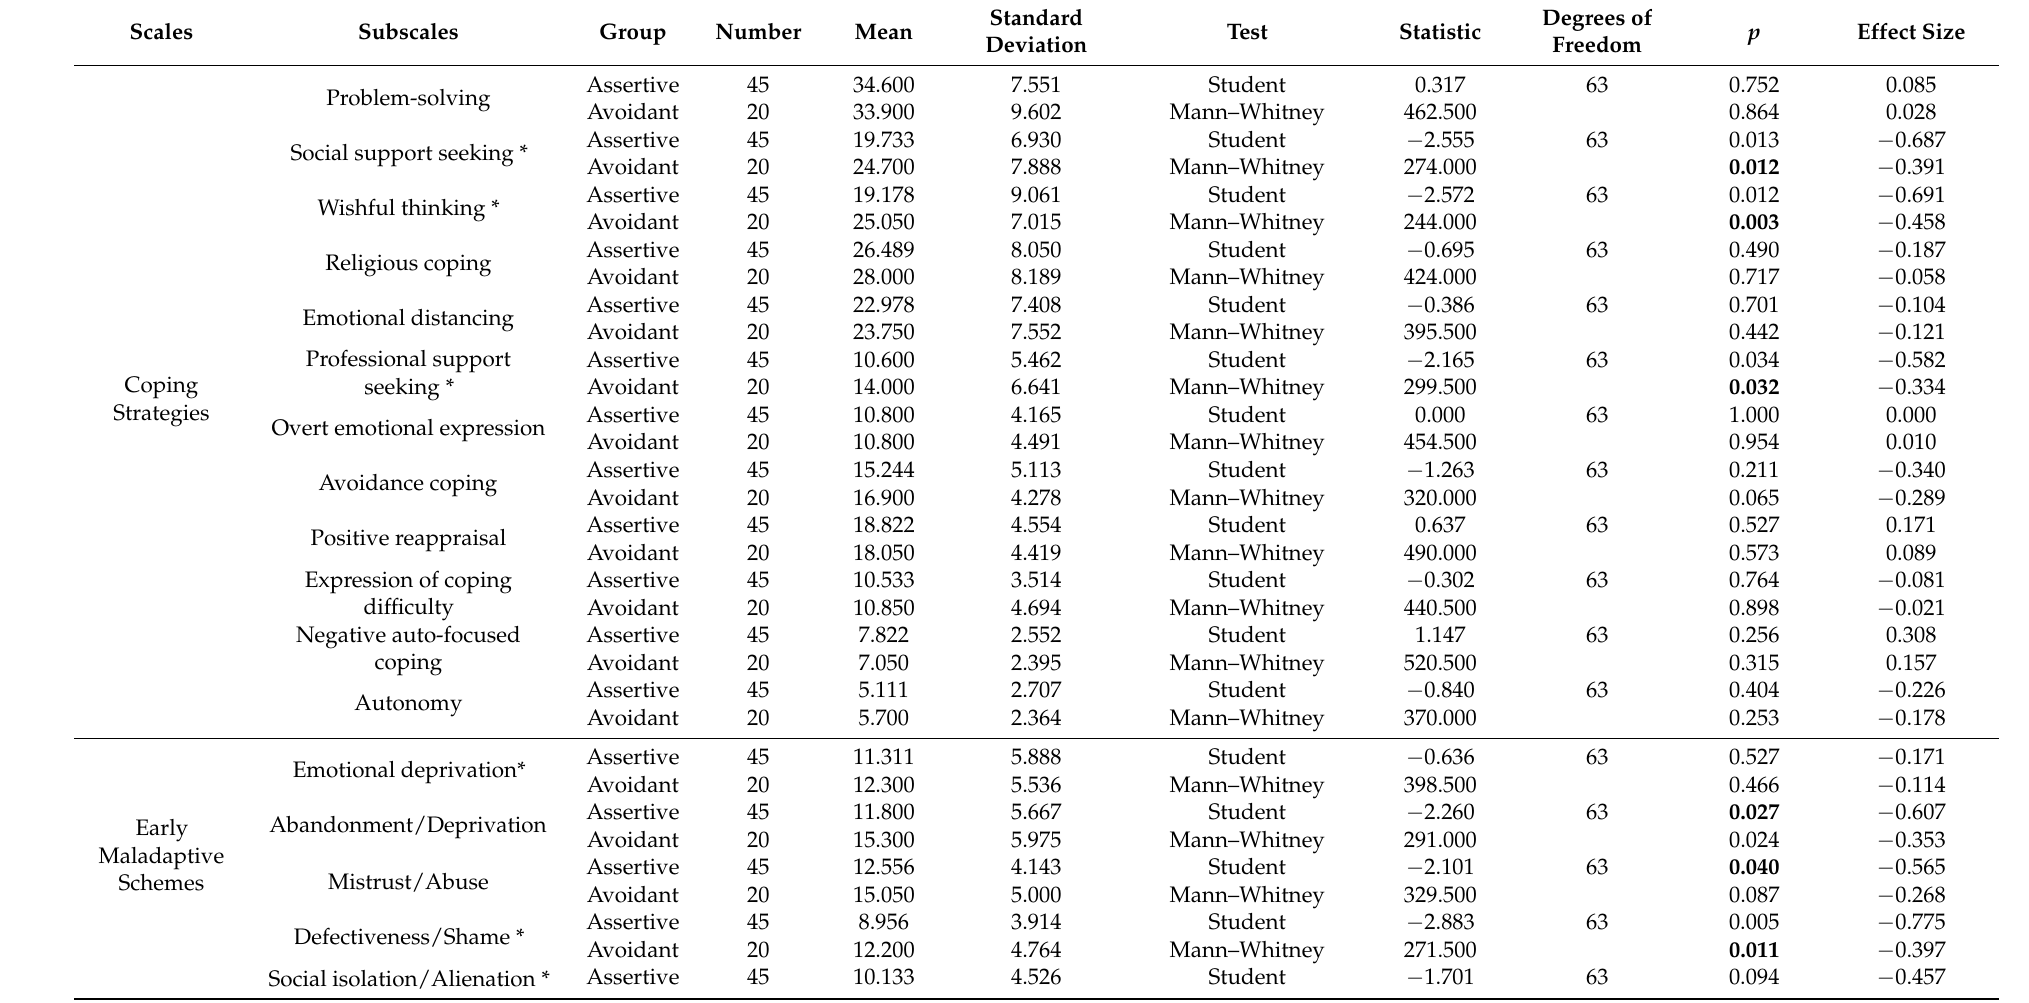
Table 2. Comparatives for coping strategies and early maladaptive schemes scores across the decisions facing humiliation with children as witnesses. Scales